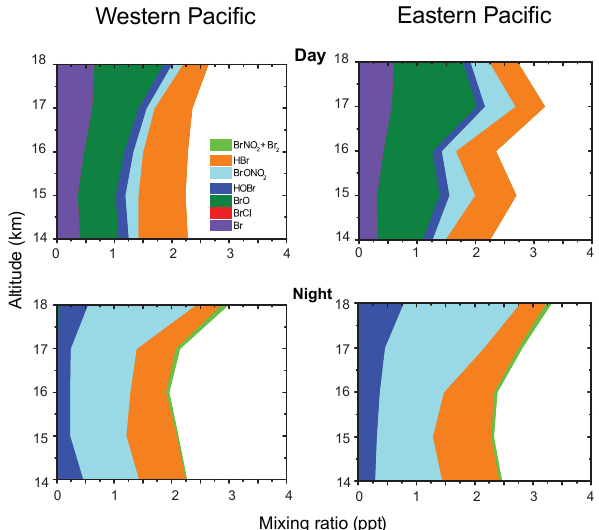
Figure 10. Inorganic bromine partitioning along ATTREX flight tracks over the western and eastern Pacific. Similar to Fig. 4, but ice aerosol recycling reactions in the CAM-Chem chemical mecha- nism were turned off in this